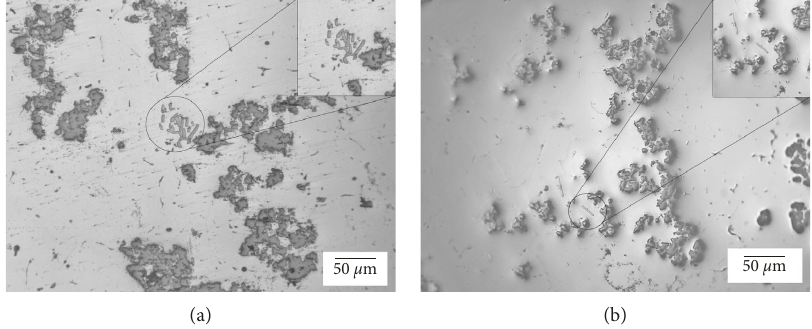
Figure 4: AlB particles’ presence in the composites with (a) 5 wt.% Zn and (b) 10 wt.% Zn. 2